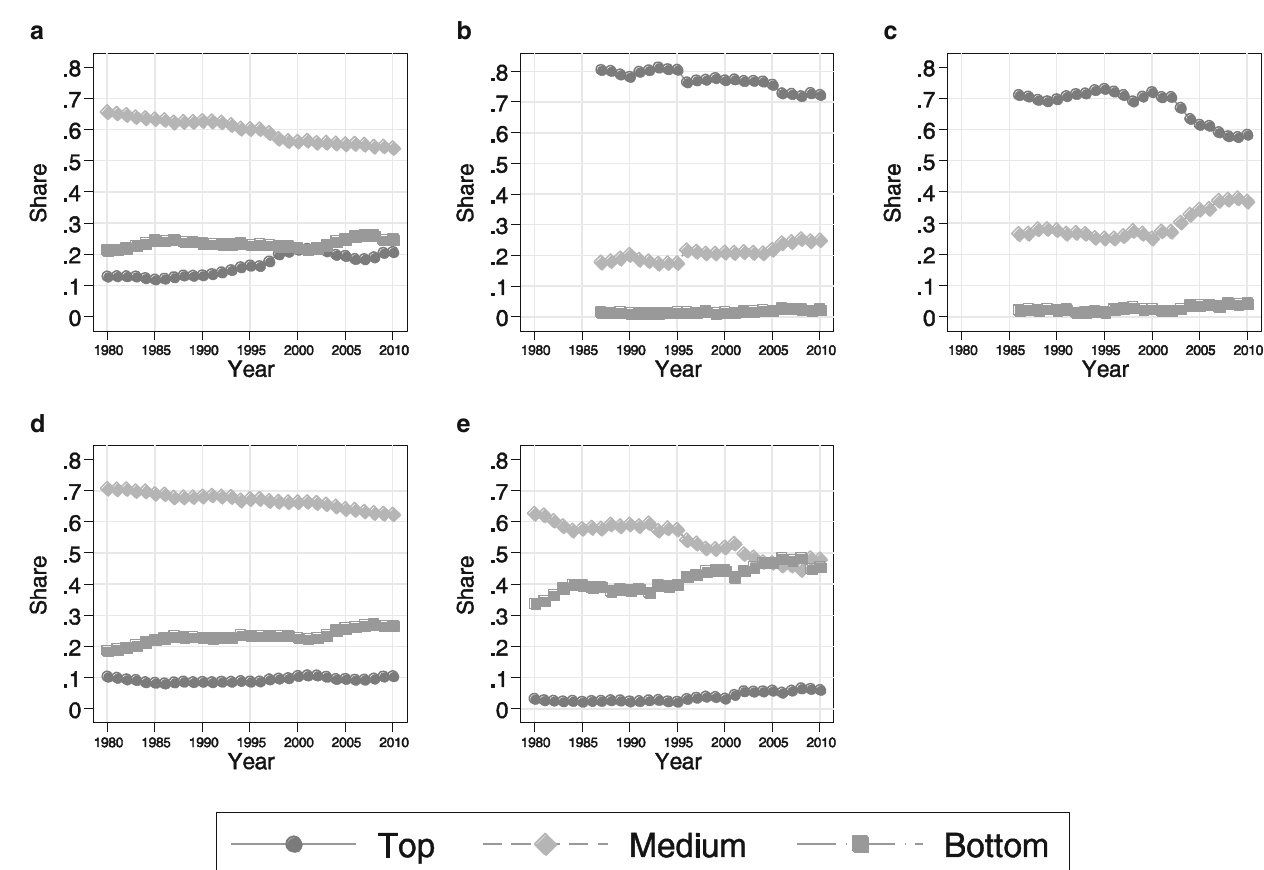
Fig. 4 Job Ordering (Four to Six Years of Experience) (Source: 2% IABS Sample for full-time workers between 25 and 35 years of age with information on job. N = 2,000,214 for all workers. Note: Jobs are ordered according to their mean wage and assigned to a percentile in the wage distribution. The calculation of mean wages is based on imputed wages following Gartner (2005). Top-jobs have a mean wage above the 70% percentile, bottom-jobs below the 30% percentile, the remaining jobs are medium-jobs. Lines represent annual shares of workers with four to six years of potential